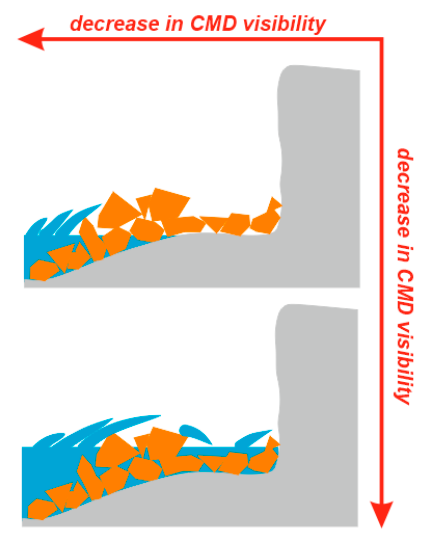
Figure 14. Dependence of coastal megaclast deposit visibility on satellite images on the sea-level